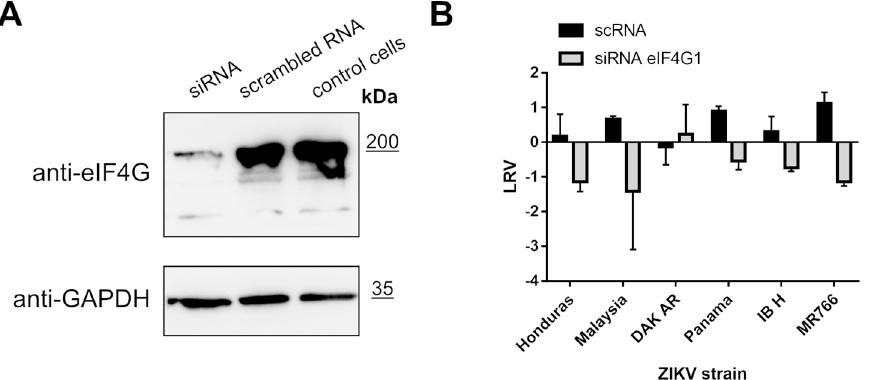
Figure 5. ZIKV replication in cells lacking eIF4G1. A549 cells were transfected with eIF4G1 siRNA or scrambled siRNA. Non-transfected controls were included. The GAPDH protein was used as a reference to ensure that identical amounts of proteins were present in each sample ( A ). ZIKV virus replication in A549 cells transfected with siRNA. The virus yield was assessed by RT-qPCR. The y-axis represents the log reduction value (LRV) in virus yield in treated samples, and the x-axis corresponds to different ZIKV strains. The assay was performed in triplicate, and average values with standard errors are presented ( B ).